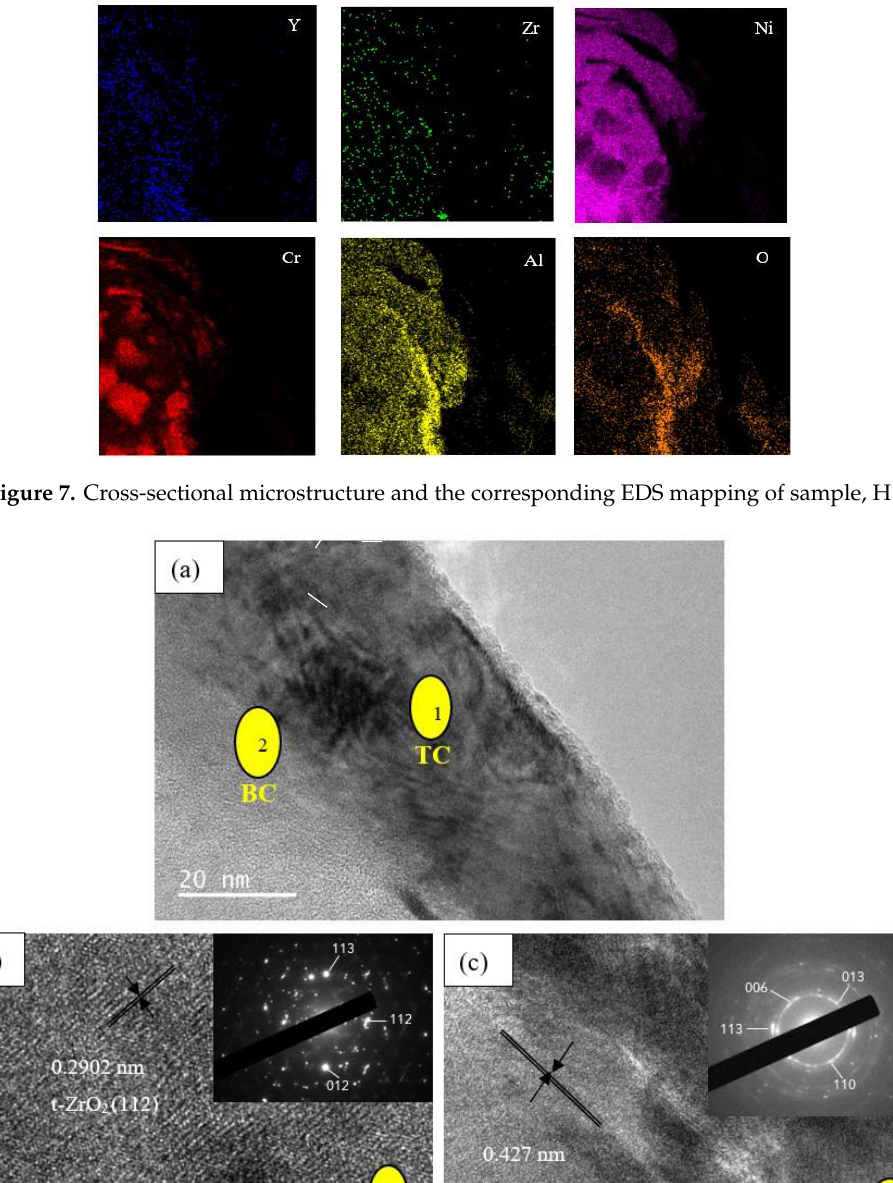
Figure 8. TEM micrograph of ( a ) TGO cross-sectional of sample H with interplanar distance and diffraction patterns at ( b ) topcoat, and ( c ) boncoat.